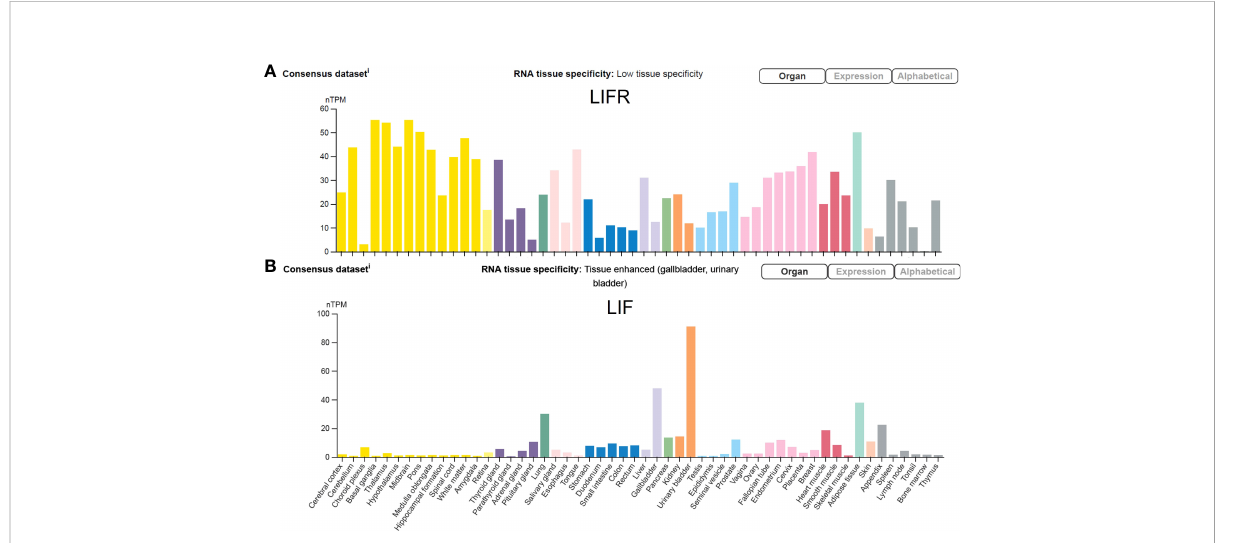
FIGURE 2 LIFR and LIF expression in human tissues. The transcripts of LIFR and LIF in 55 healthy human tissues are displayed at normalized expression levels (nTPM) that are created by combining transcriptomics datasets of The Human Protein Atlas (HPA) project and The Genotype-Tissue Expression (GTEx) project. Figure is available from The Human Protein Atlas website (accessed on August 15,